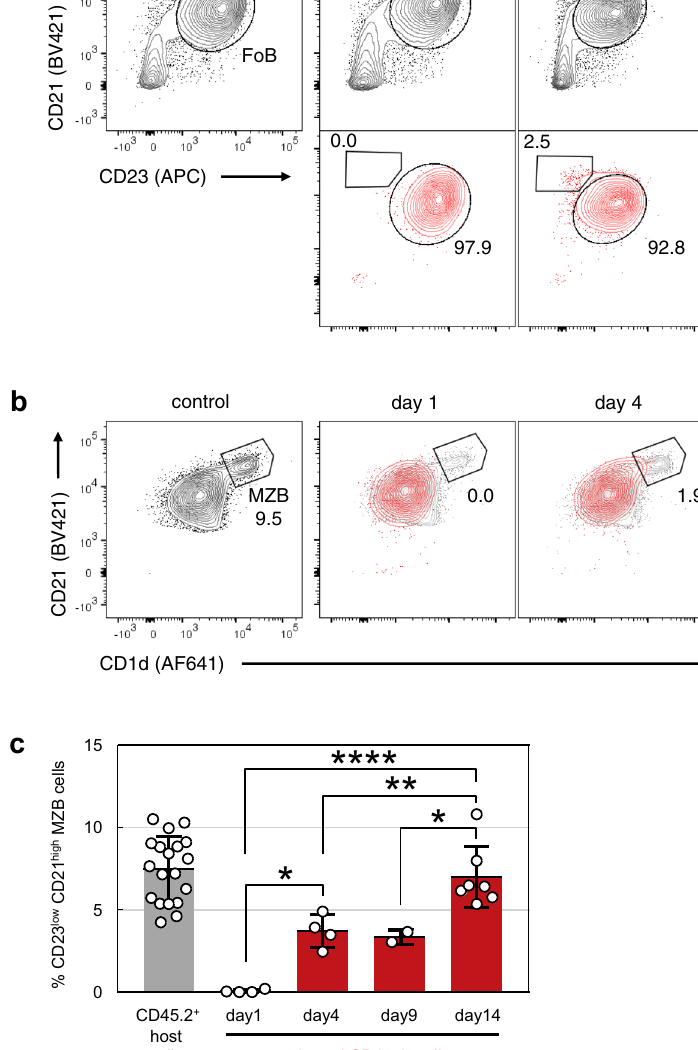
Fig. 6 FoB cells convert to MZB cells after adoptive transfer. Flow cytometric analyses of surface phenotypes of recovered CD45.1 + cells in the spleen of recipient CD45.2 + mice at the indicated time points after adoptive transfer of puri fi ed FoB cells. a Representative plots of CD23/CD21 surface phenotype. Cells were gated on B220 + B cells and then separated for CD45.2 + recipient cells (black) or corresponding CD45.1 + recovered donor cells (red). The numbers indicate the percentages of MZB and FoB cells within CD45.1 + cells. b Representative overlays of an CD1d/CD23 surface staining of recovered CD45.1 + cells (red) and CD45.2 + recipient cells (gray) at the indicated time points after transplantation. The numbers indicate the percentages of MZB within CD45.1 + cells. c Summary and quanti fi cation of percentages of CD23 low CD21 high MZB cells among CD45.1 + cells at different days after transfer. Bar graph shows mean values, SD and individual data points n = 4 (d1), n = 4 (d4), n = 2 (d9), n = 7 (d14) independent experiments. (* p = 0,0111, **** p = 1.0E − 05, ** p = 0,0093, * p = 0,0249, one-way ANOVA, Tukey´s multiple comparison test, only CD45.1 + cells are